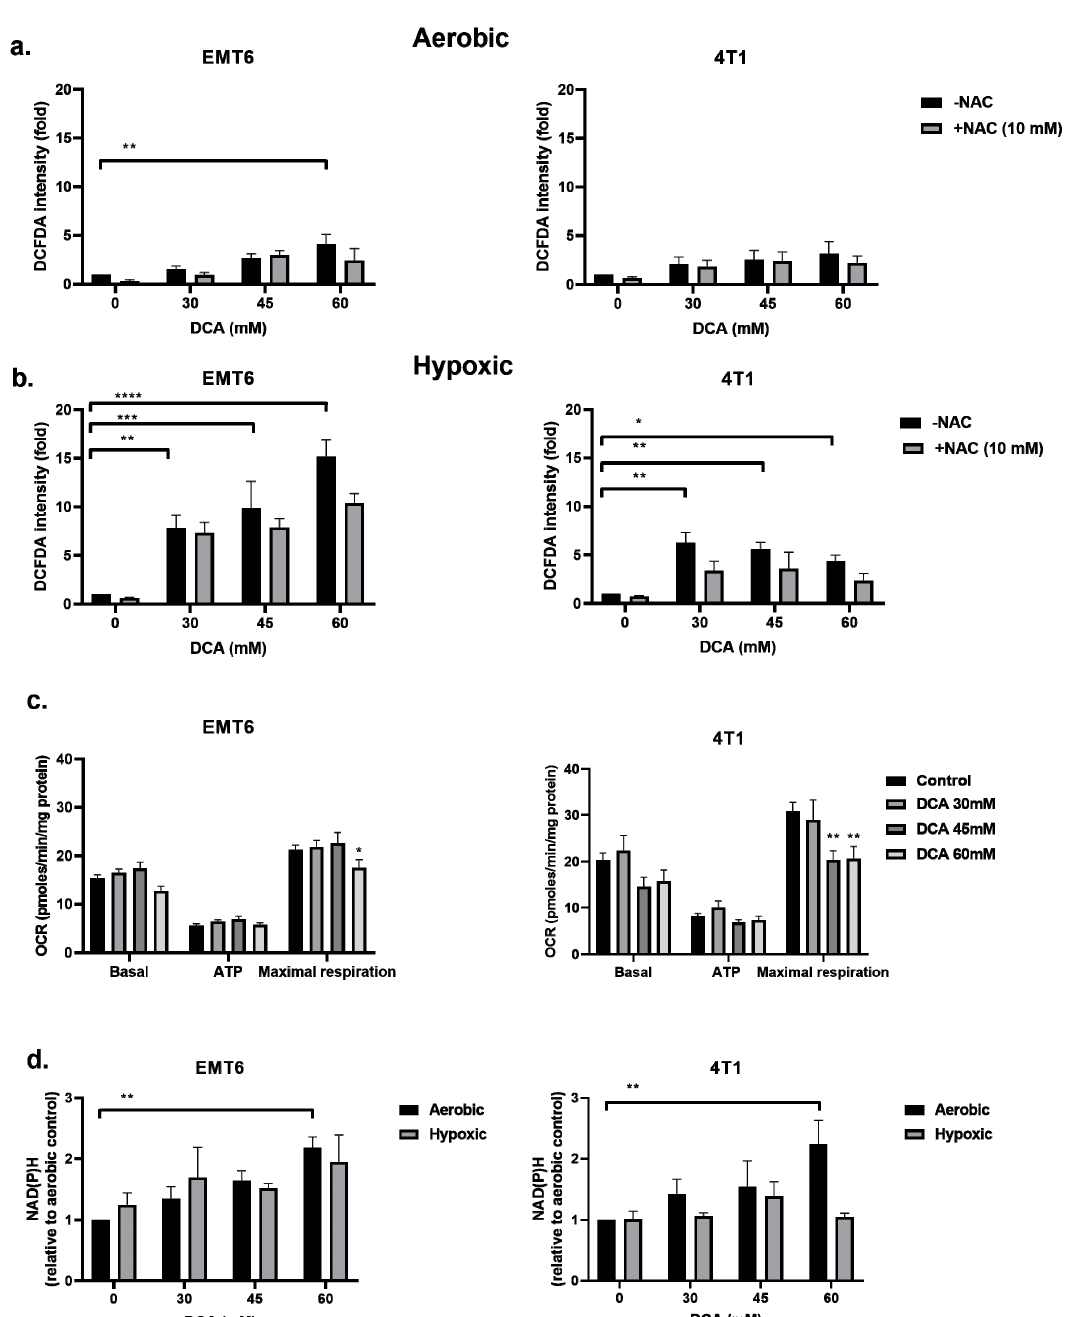
Figure 3. DCA induces ROS production in hypoxic cells by overloading the mitochondrial metabolism. EMT6 and 4T1 cells were treated with DCA overnight at indicated concentrations, and N-acetyl-cysteine (NAC) (10 mM) was added 1 h prior to and during treatment. ROS generation was measured by flow cytometry using CM-H2DCFDA probe under aerobic ( a ) and hypoxic ( b ) conditions. ( c ) Oxygen consumption rate (OCR) measurements were obtained over time by a Seahorse analyzer using the mitochondrial stress test. To extract detailed information on the electron transport chain in mitochondria, specific inhibitors consisting of oligomycin, FCCP, rotenone and antimycin A were added sequentially. Basal mitochondrial OCR, ATP-linked OCR and maximal OCR were calculated from these results. ( d ) NAD(P)H was measured by flow cytometry using a JZL1707 NAD(P)H sensor under aerobic and hypoxic conditions. * p < 0.05, ** p < 0.01, *** p < 0.001, **** p < 0.0001.